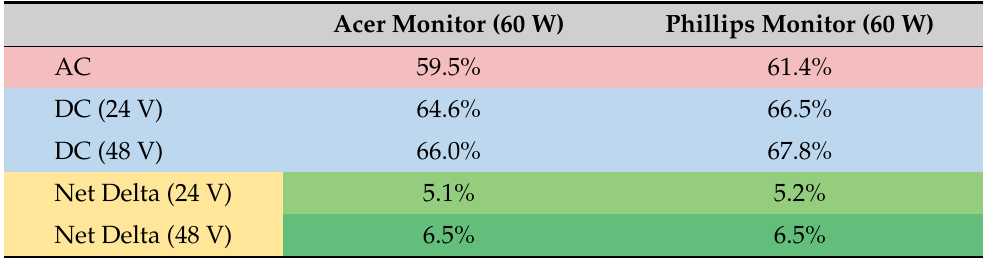
Figure 5. AC and DC weighted energy efficiencies for flat panel display screens: Acer CB421HYK (60 W) in ( a , b ) and for Phillips 288P6L (60 W) in ( c , d ). Simulations were done with 70 W SIMO test converters. Panels ( a , c ) show a comparison with DC test converter rated at 24 V DC and panels ( b , d ) at 48 V DC . Efficiency curves for the test converters are represented by the dotted lines, and the frequency when the appliance is on for each power bin is by the bar chart. Table 7. Delta Efficiency (DC-AC) for simulations with converters rated at 70